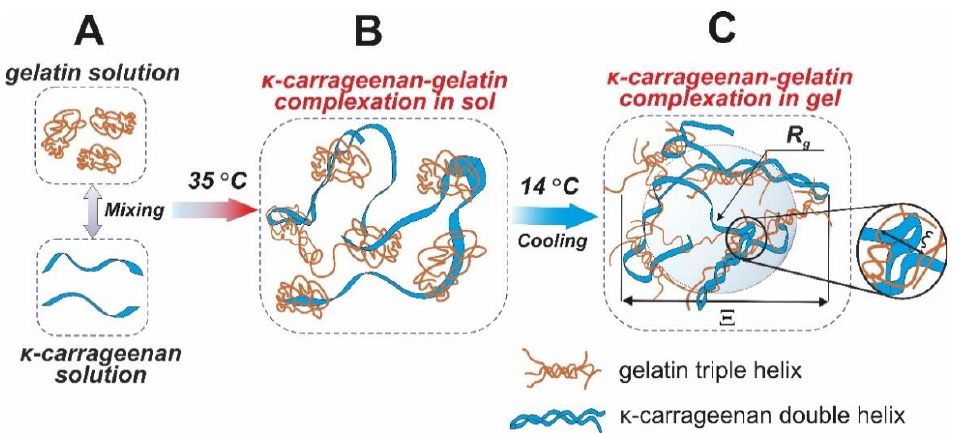
Figure 10. Structural schemes of κ -carrageenan and gelatin initial conformation ( A ), structural details of κ -carrageenan and gelatin complexation ( B ) and supramolecular polysaccharide–protein hydrogel ( C